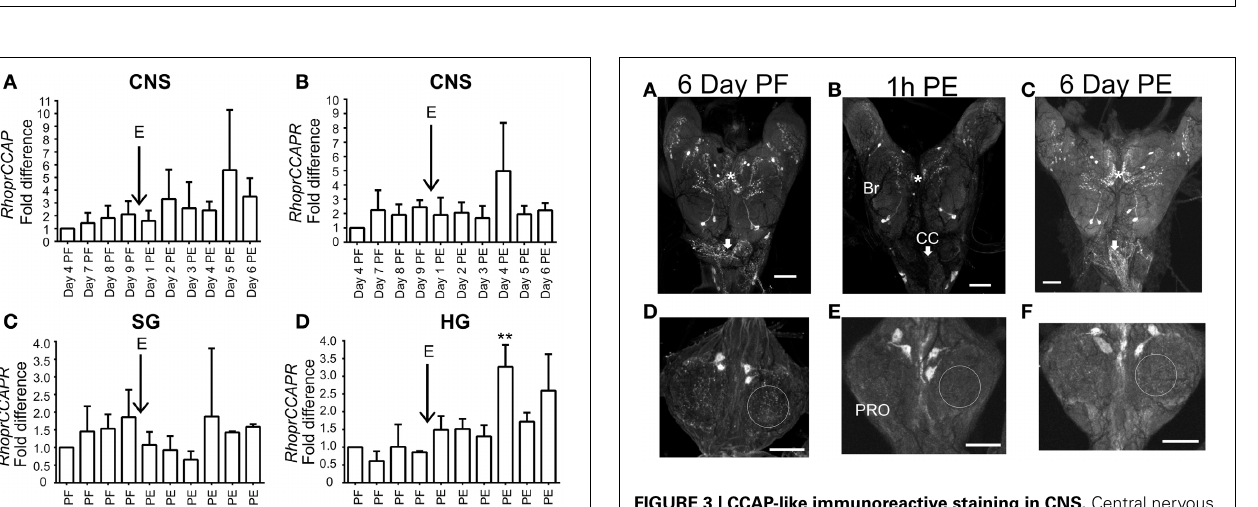
FIGURE 1 | Temporal sequence of pre-ecdysis, ecdysis, and post-ecdysis behaviors in 4th instar Rhodnius prolixus . All characteristic behaviors during the different stages are boxed in